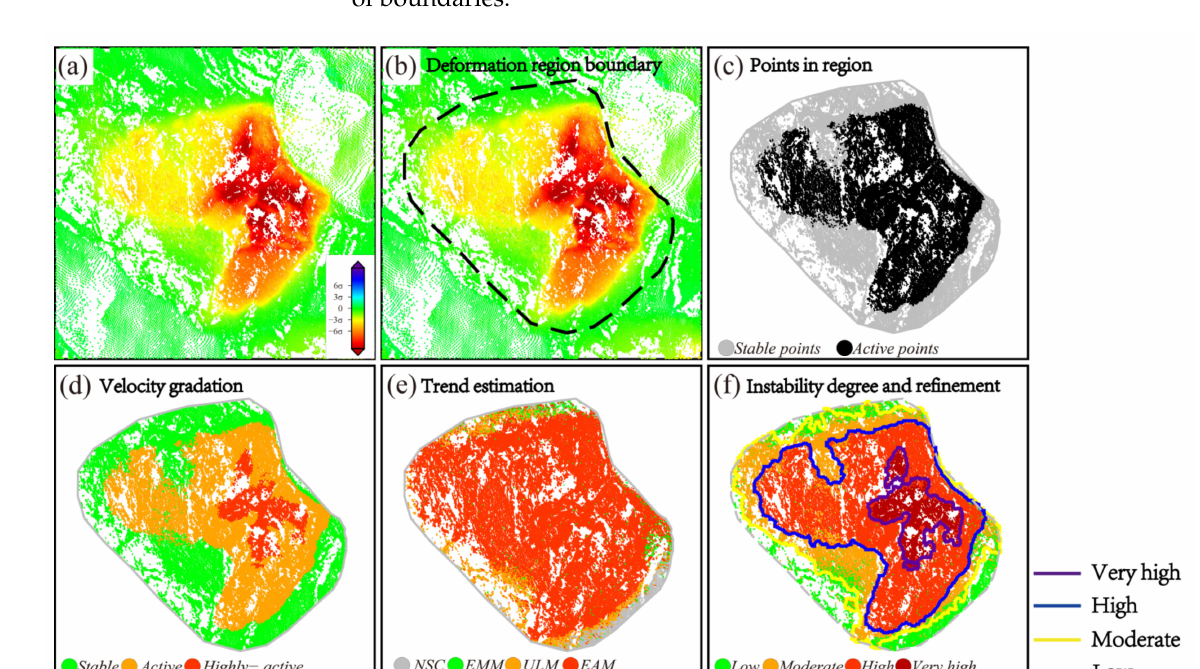
Figure 2. The result of each step of the improved method. ( a ) the average deformation velocity, ( b ) the deformed region boundary obtained by cluster analysis, ( c ) active and stable points in the deformed region. The results of ( d ) velocity gradation, ( e ) temporal evolution trend estimation, and ( f ) instability degree and refined boundaries.